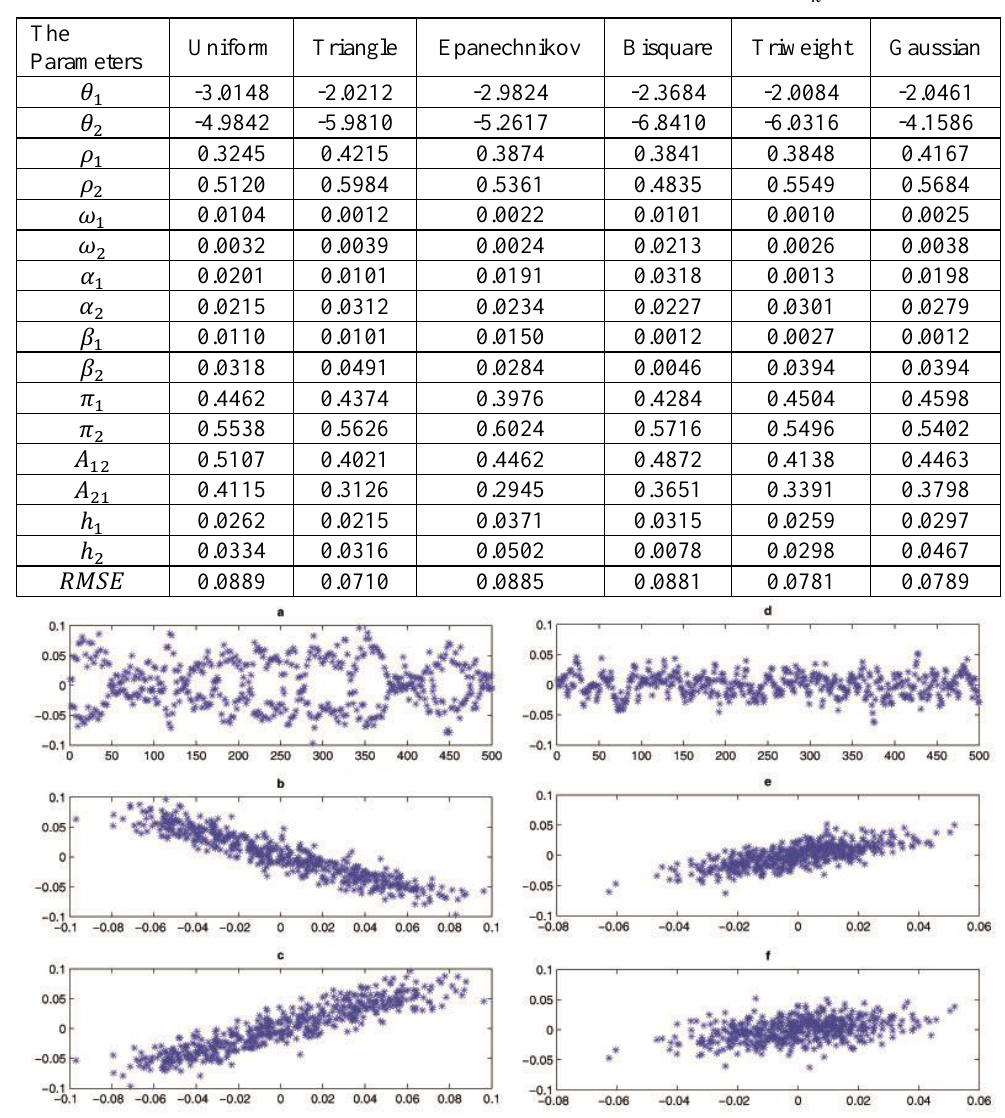
Figure 2. For nonlinear function ( ) ( ) : {(a). Simulated data, (b). Scater plot of ( ) , (c). Scater plot of ( ) }, For nonlinear function ( ) ( ) : {(d). Simulated data, (e). Scater plot of ( ) , (f). Scater plot of ( )